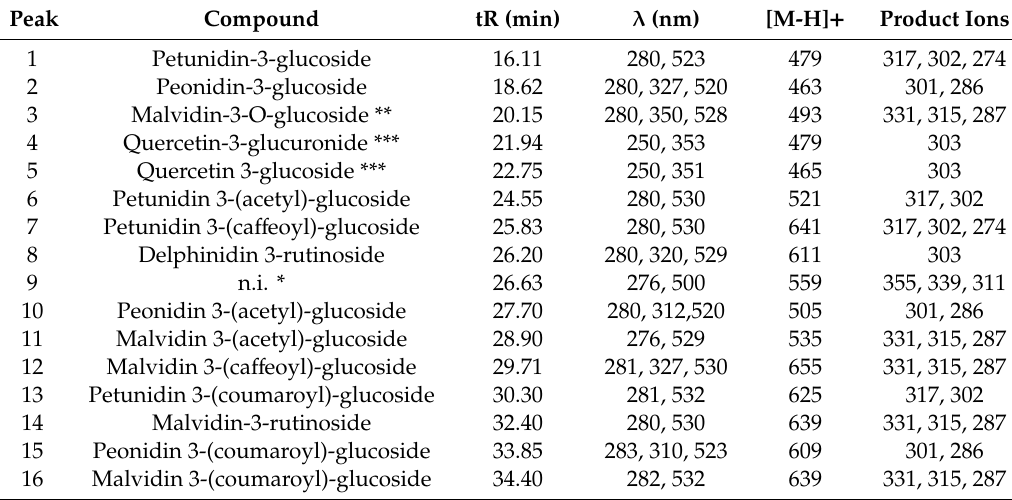
Figure 3. Chromatograms of the characterization of grape marc extracts obtained from an ultrasound assisted extraction (UAE). ( a ) HPLC-DAD-ESI-MS / MS analysis; ( b ) ultra-performance liquid chromatography (UPLC) analysis. Table 2. Liquid chromatography-mass spectrometry LC-MS data of phenolic compounds from the extract obtained by